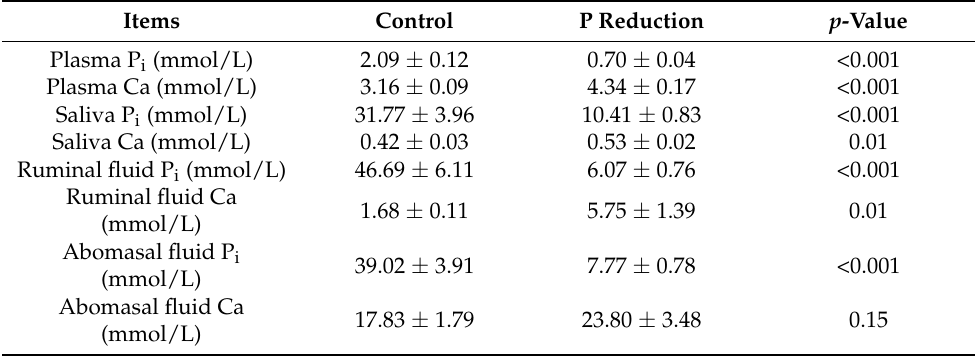
Table 3. Inorganic phosphate (P i ) and calcium (Ca) concentrations in saliva, ruminal and abomasal fluids of young goats fed a low phosphorus (P) diet. (Mean values with their standard errors; n = 7